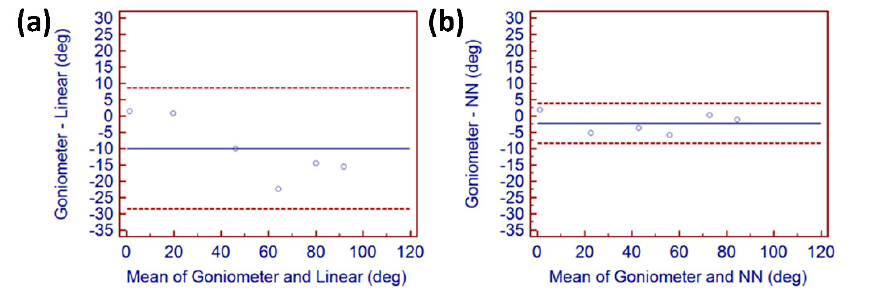
Figure 6. Bland–Altman agreement technique for little MCP. ( a ) demonstrates level of agreement between goniometer and angles generated from glove data. ( b ) demonstrates agreement between goniometer and NN angular calculation.